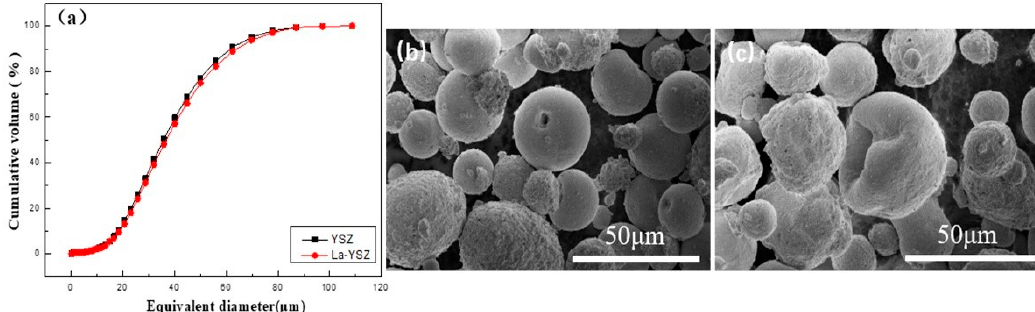
Figure 1. ( a ) Equivalent diameter distribution of powders, morphologies of ( b ) Yttrium oxide-stabilized zirconia (YSZ) powders and ( c ) La-YSZ powders.